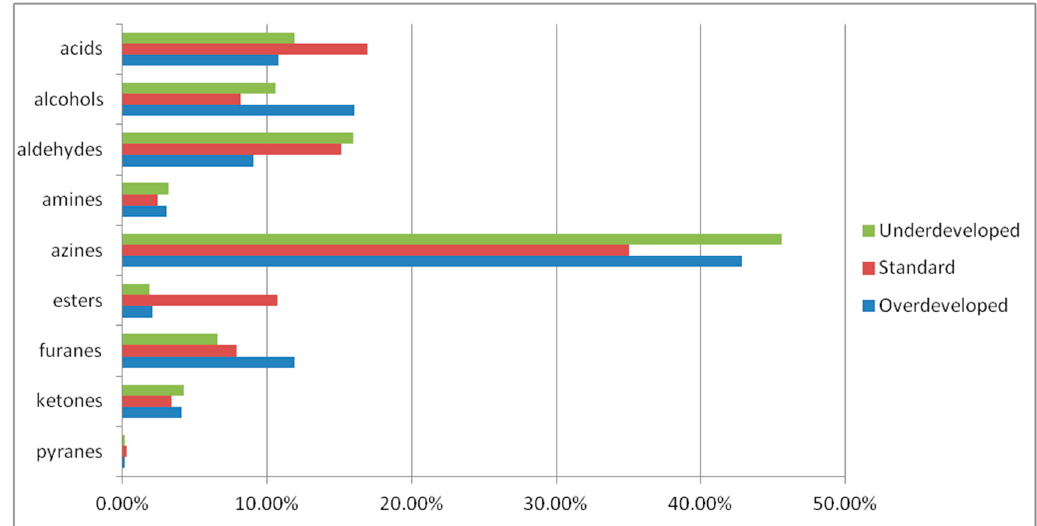
Figure 1. Percentage of the chemical classes of the volatile components of the 3 types of roasted coffee determined in the chromatographic analysis. Table 2. Volatile compounds determined in the chromatographic analysis. %—percentage share of the compound with standard deviations in the tested sample immediately after roasting of under- developed, standard, and overdeveloped conditions.